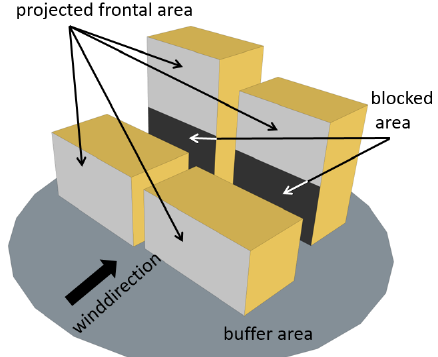
Figure 5. ‘Frontal area index’ calculation within a buffer using LoD1